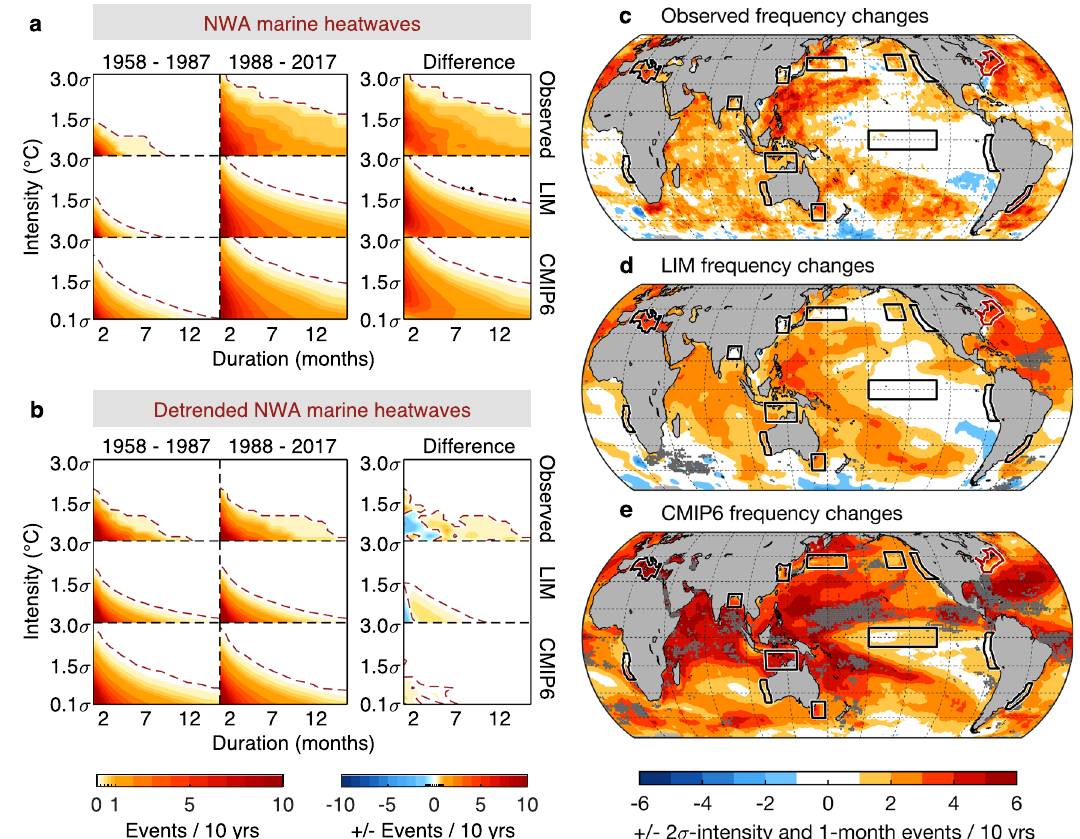
Fig.5|ImpactofchangesinthetrendonMarineHeatwave(MHW)occurrences. a Northwest Atlantic (NWA) MHW frequencies (events per decade) over a range of intensities and duration, i.e., Intensity-Duration-Frequency (IDF) plot, during 1958 – 1987 ( fi rst column), 1988 – 2017 (second column) and their difference (third column).First/second/thirdrowisderivedfromobservedSeaSurfaceTemperature Anomaly (SSTA)/trend+(LIM5887 ensemble, LIM8817 ensemble)/CMIP6 (see Methods). Dashed lines represent the contour level of 0.1 events (red) or − 0.1 events (blue)per decade(i.e., ±1 event percentury).Blackdotsinthe third column mark observed values that are 95% signi fi cantly different from the climate